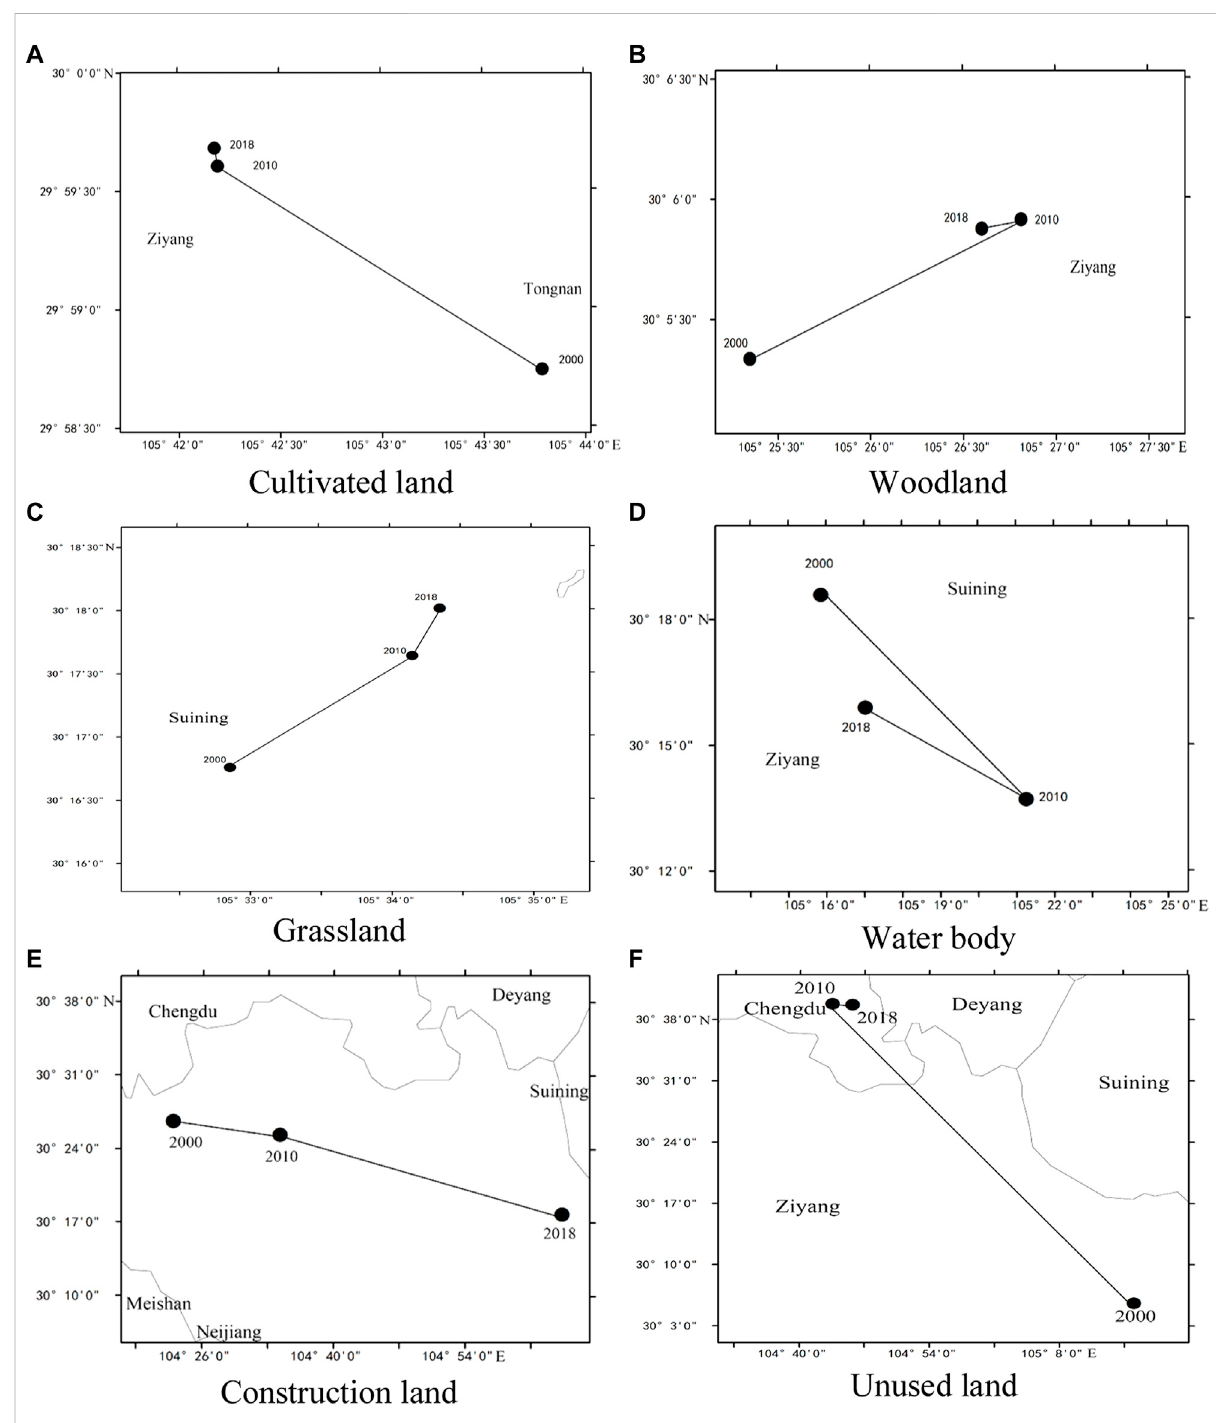
FIGURE 5 (A – F) arerespectivethechangesofthegravitycenterofcultivatedland,woodland,grassland,waterbody,constructionland,andunusedlandin the study area, 2000 –